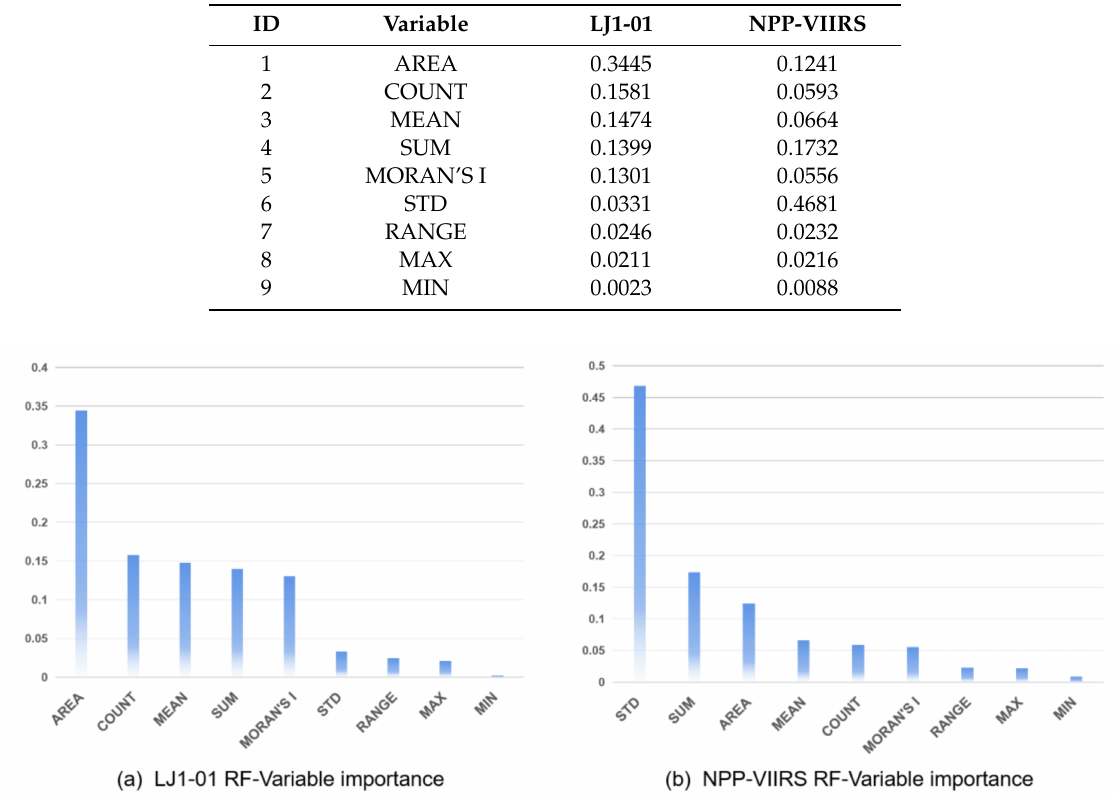
Figure 6. Importance of the nine variables in the RF model: ( a ) LJ1-01 NTL and ( b ) NPP-VIIRS NTL.